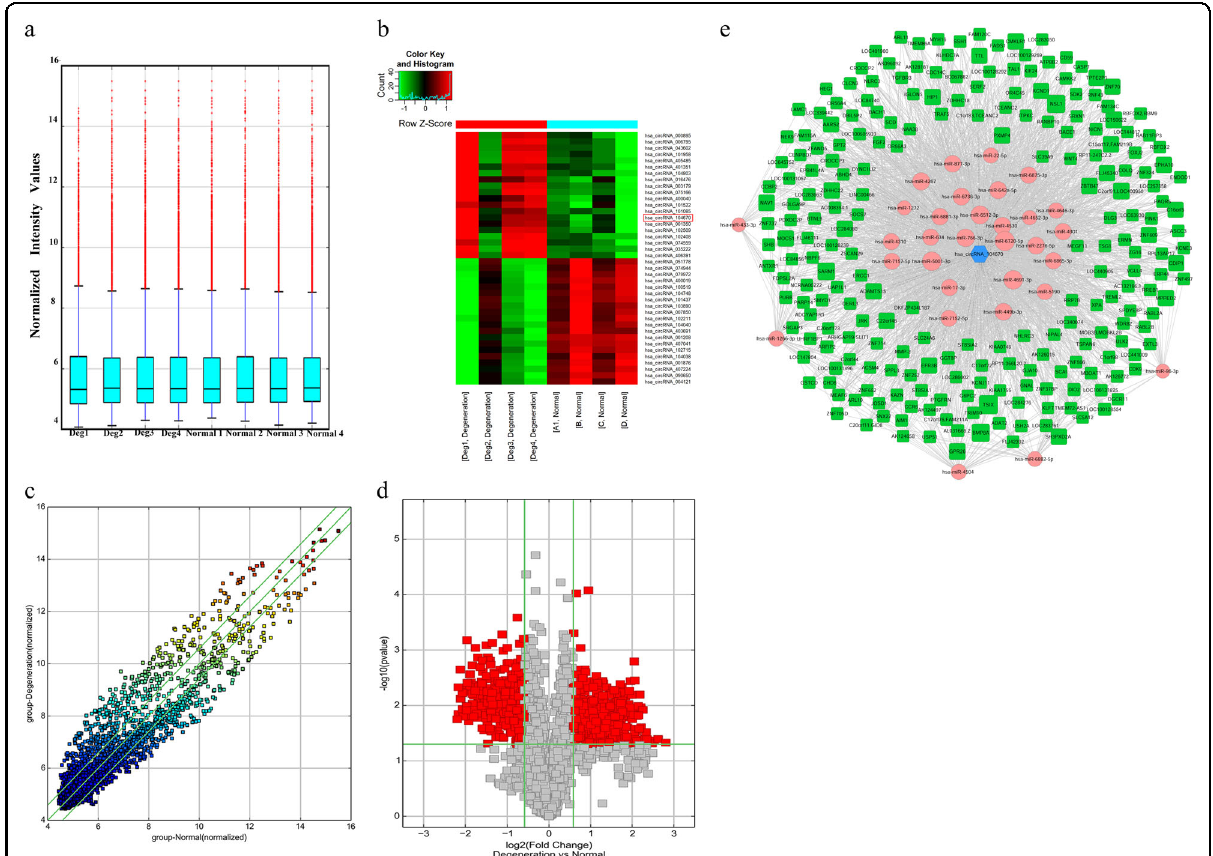
Fig. 1 Differential expression of circRNAs in degenerative and normal NP tissues and ceRNA analysis for circRNA_104670. a The expression levels of circRNAs were recorded by a box plot as the mean ± standard deviation in the degenerative and normal NP groups. b Hierarchical clustering recorded the top 20 differentially expressed circRNAs between degenerative and normal NP tissues. The expression values are represented in different colors; red indicates high expression levels, and green indicates low expression levels. The red box indicates the selected circRNAs. c A scatter plot was used to evaluate the variation in circRNA expression. The values of the X and Y axes in the scatter plot correspond to the normalized signal values of the samples (log 2 scaled). The green lines are fold-change lines, the circRNAs above the top green and below the bottom line indicate greater than 1.5-fold changes between the two groups ( p < 0.05). d Volcano plots were used to show differential expression of circRNAs. The vertical lines correspond to 1.5-fold up- and downregulation, with a p value of 0.05. The red point outside of the vertical lines in the plot shows the number of circRNAs that were differentially expressed with statistical signi fi cance between the two groups. e The interactions were speci fi cally described basing on circRNA microarray and mRNA microarray data. In this network, 31 miRNAs were closely connected with circRNA_104670, while 26 miRNAs ranker higher. The hexagon at the center of the network indicates circRNA_104670, and the pink circles represent miRNAs that bound to this circRNA. The green quadrilaterals indicate target genes (miRNAs). The predicted interactions of ceRNA in the IDD process is circRNA_104670-miR-